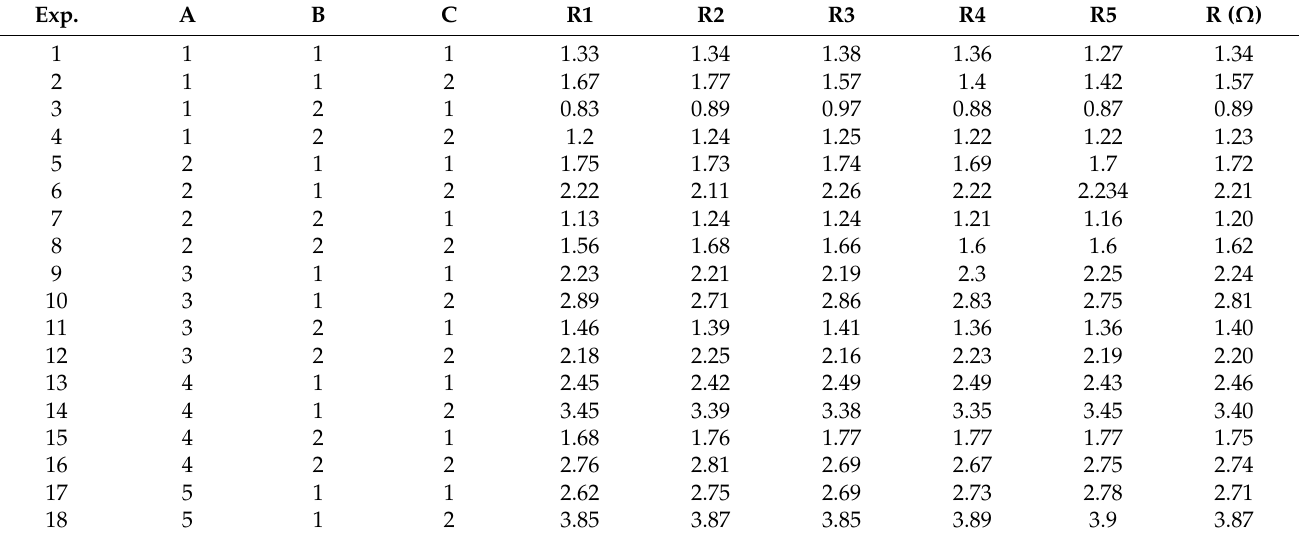
Table 7. Measured values of